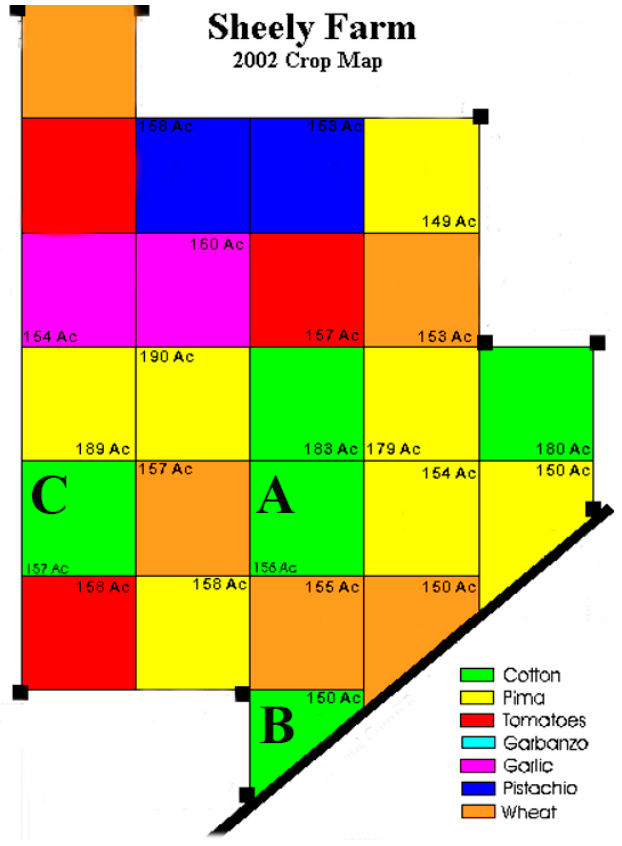
Figure 6. Three plots shown on the Sheely Farm crop map.